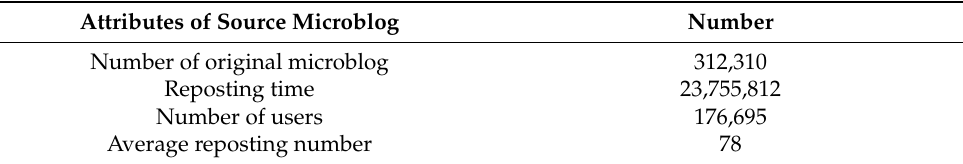
Table 3. Some attributes of the data